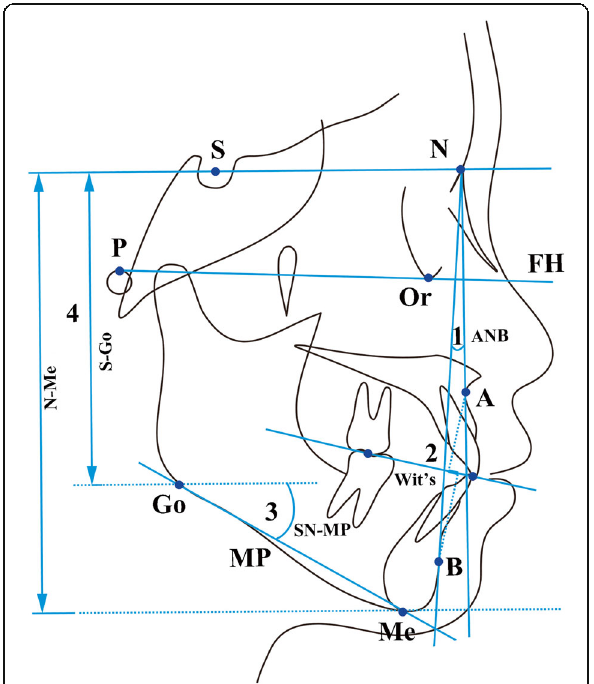
Fig. 2 Measurements to classify sagittal and vertical skeletal malocclusion. A, A-point, deepest bony point on the contour of the premaxilla below ANS; B, B-point, deepest bony point on the contour of the mandible above pogonion; ANB, angle between point A, B and point N; 1. Wits, perpendicular lines are dropped from points A and B onto the occlusal plane, Wits is measured from Ao to Bo; 2. S, sella, center of sella turcica; N, nasion, the most anterior limit of the frontonasal suture on the frontal bone in the facial midline; SN, connection between S and N, stands for anterior cranium base plane; Go, gonion, the most posterior inferior point of mandible angle; Me, menton, most inferior point of the bony chin; MP, connection between Me and Go, stands for mandibular plane; SN- MP, angle between SN and MP; 3. S-Go, the distance between lines parallel to FH plane passing through S and Go, represents the posterior facial height; N-Me, the distance between lines parallel to FH plane passing through N and Me, represents for the anterior facial height; FHI(S-Go/N-Me), facial height index, the ratio of posterior and anterior height, stands for vertical growth pattern of